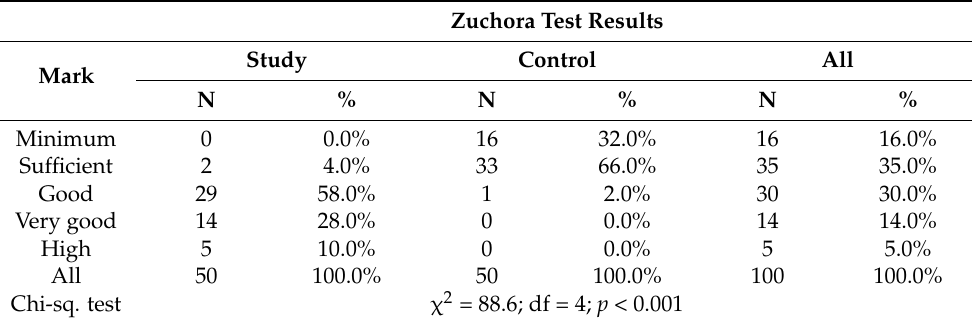
Table 5. Distribution of grades awarded on the basis of the Zuchora test result and the applicable standards.